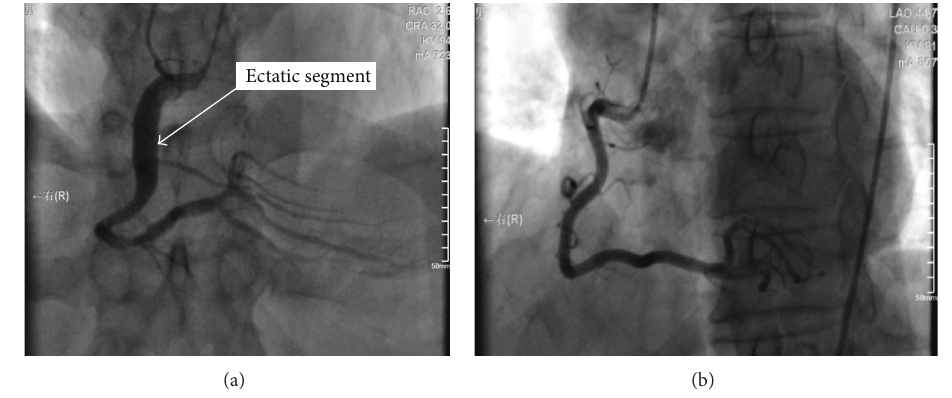
Figure 1: (a) Coronary angiogram showing right coronary ectasia. (b) Normal right coronary angiogram.